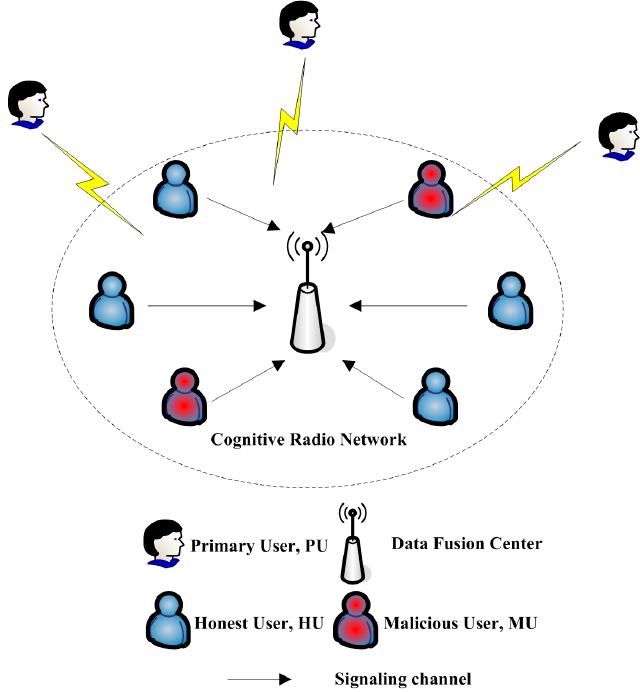
Figure 1. Centralized collaborative spectrum sensing system model.